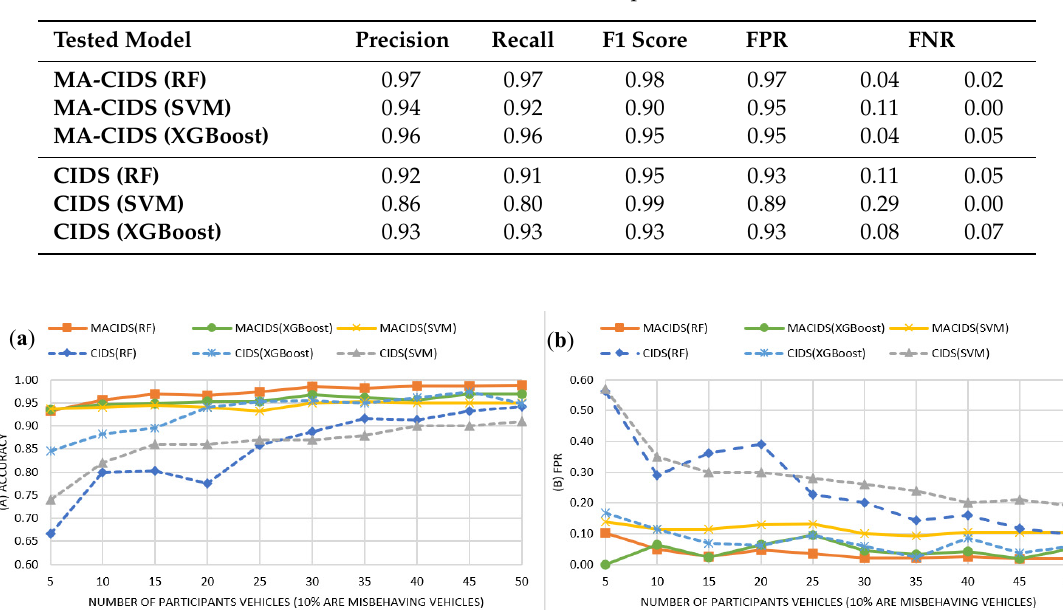
Table 4. Details of the detection performance.